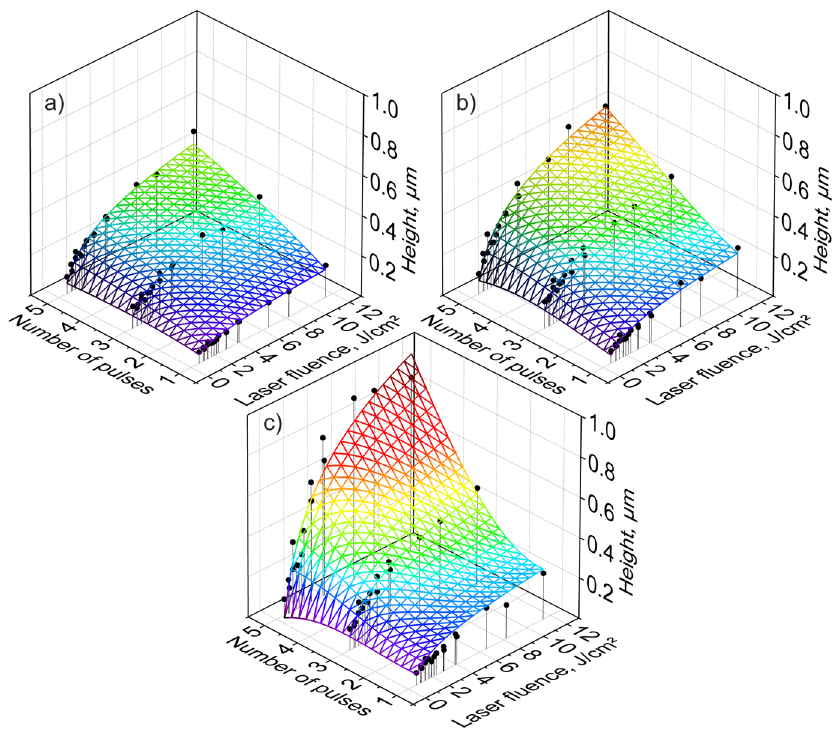
Figure 3. Depth of the produced hole-like patterns as a function of the applied number of laser pulses and laser fluence for ( a ) 5.7 µ m, ( b ) 2.6 µ m and ( c ) 1.8 µ m spatial periods.